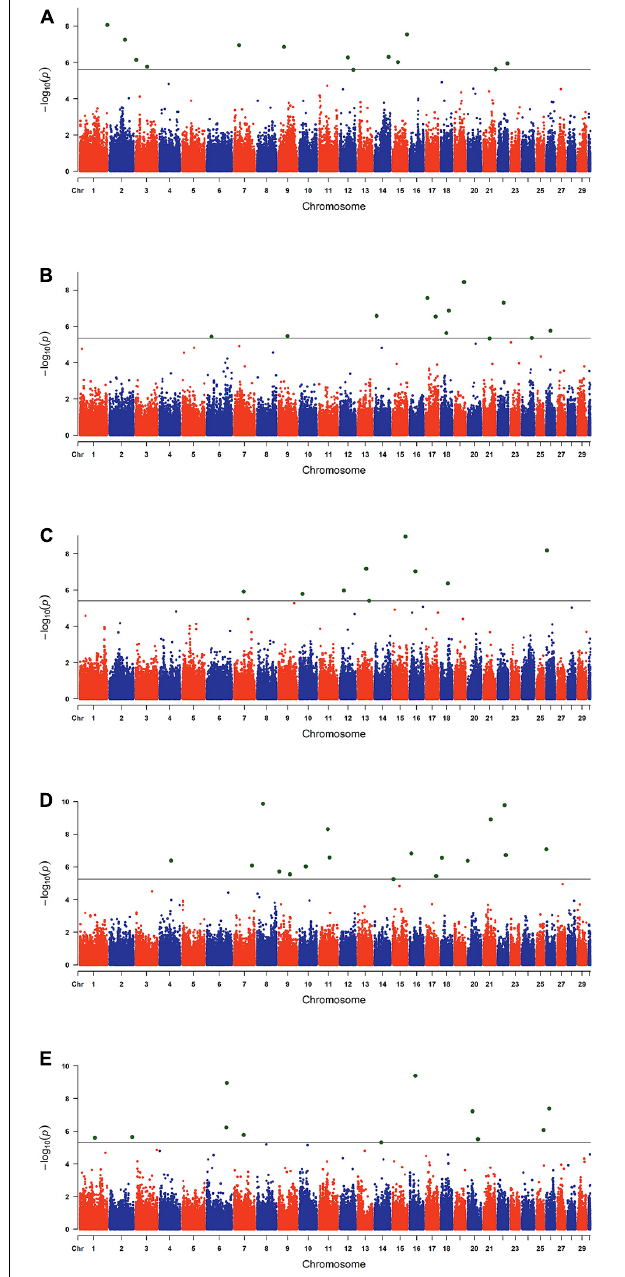
FIGURE 4 | Manhattan plots of the genome-wide association studies for the genetic effects of the dam on reproductive traits. The x -axis and the y -axis represent the chromosome number and the observed − log 10 ( P − value ) , respectively. The single-nucleotide polymorphisms were plotted against their genomic positions. The lines in the plots indicate the thresholds of false discovery rate (0.05) in the corresponding traits: (A) conception rate, (B) 56-day non-return rate, (C) calving ease, (D) stillbirth, and (E) gestation length.